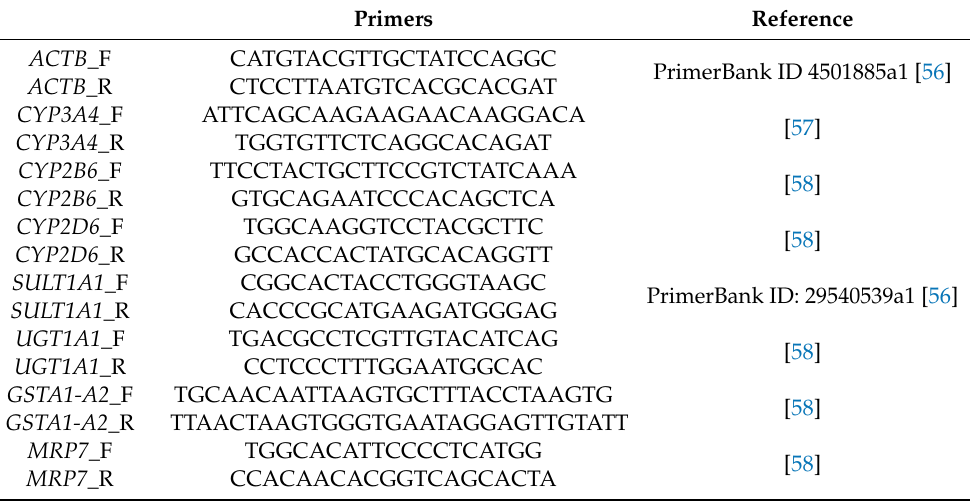
Table 3. Primers used for qRT-PCR characterization of NVP treated and non-treated HLCs, hnMSCs. Primers